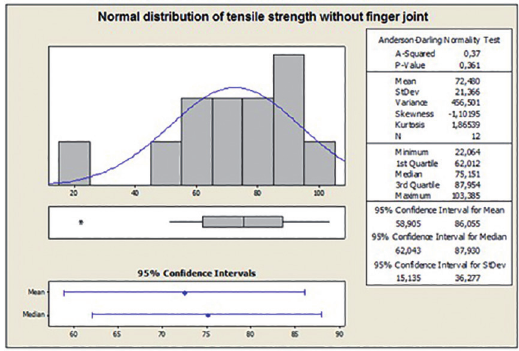
Figure 9: Histogram showing tensile strength values for samples without finger joints.